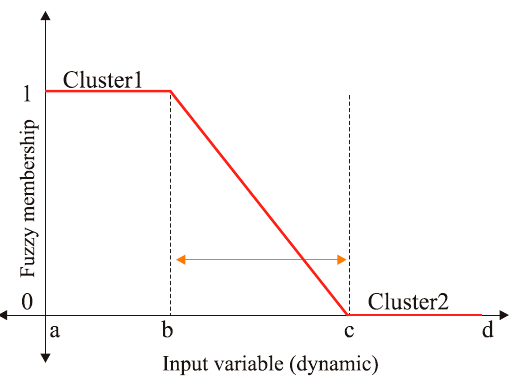
Figure 8. The membership function of a two-cluster fuzzy variable.